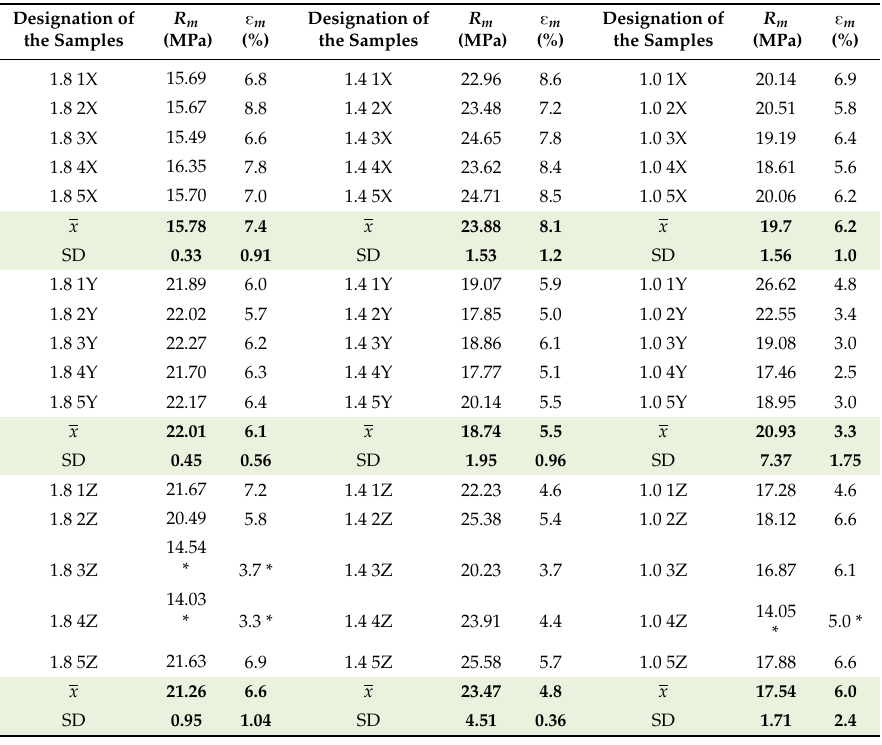
Table 3. Tensile strength and maximum percentage strain.